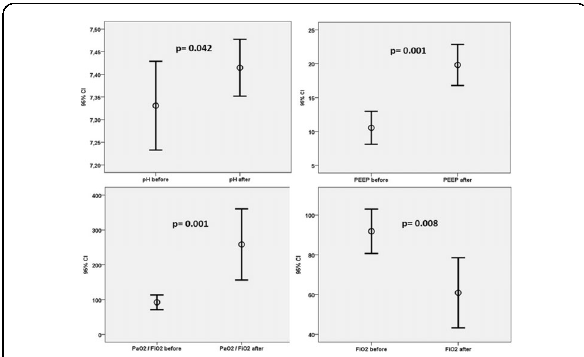
Fig. 1 (abstract 001029). Respiratory parameters before and after esophageal catheter replacement and titrating PEEP according to transpulmonary pressure measurement. Circles represent mean values and lines represent 95% confidence